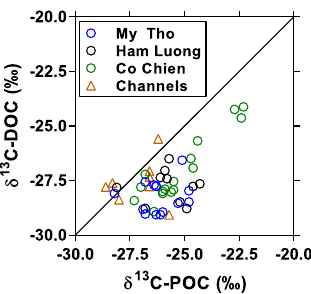
Figure 7. Stable isotope composition of dissolved organic carbon ( δ 13 C-DOC, ‰) as a function of the stable isotope composition of particulate organic carbon ( δ 13 C-POC, ‰) in the three branches of the Mekong delta (M e y Tho, Hàm Luông, and C ´ˆ o Chiên) and side channels in October 2004. The solid line indicates the 1:1